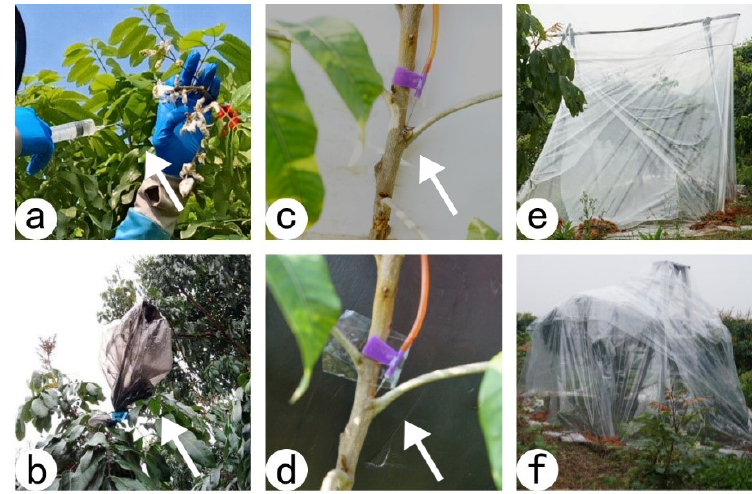
Figure 1. Display of three methods for 2n pollen induction. ( a , b ) Cotton soaking with colchicine. ( c , d ) Injection with colchicine using an infusion apparatus (showed by the arrows). ( e , f ) High-tem- perature treatment with trees covered by plastic shed and heated with unit heater.